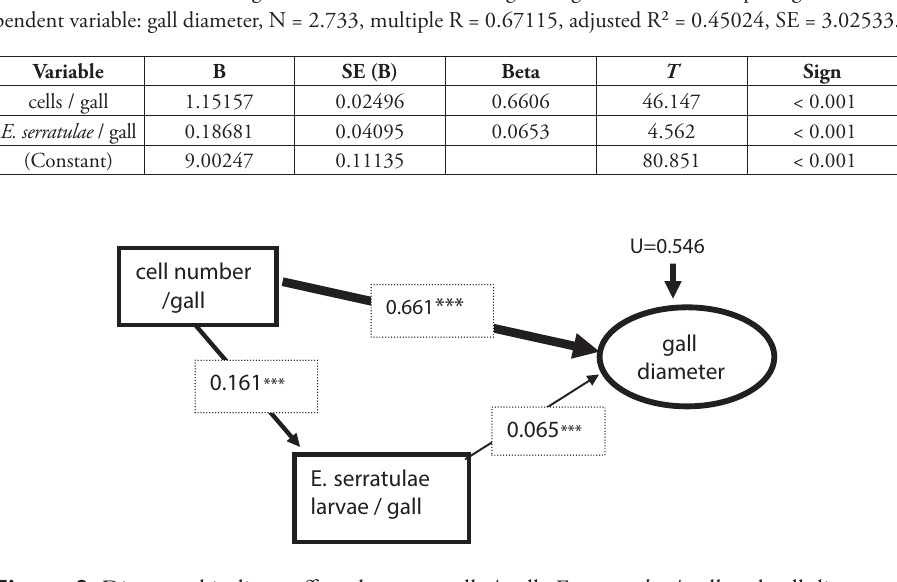
Figure 9. Direct and indirect effects between cells / gall, E. serratulae / gall and gall diameter. Path diagram: all three path coefficients (beta values) are significant at p < 0.001. Multiple R 2 = 0.4546. U (coefficient of non-determination) = 0.5456 ( N = 2,733 U. cardui galls with E. serratulae